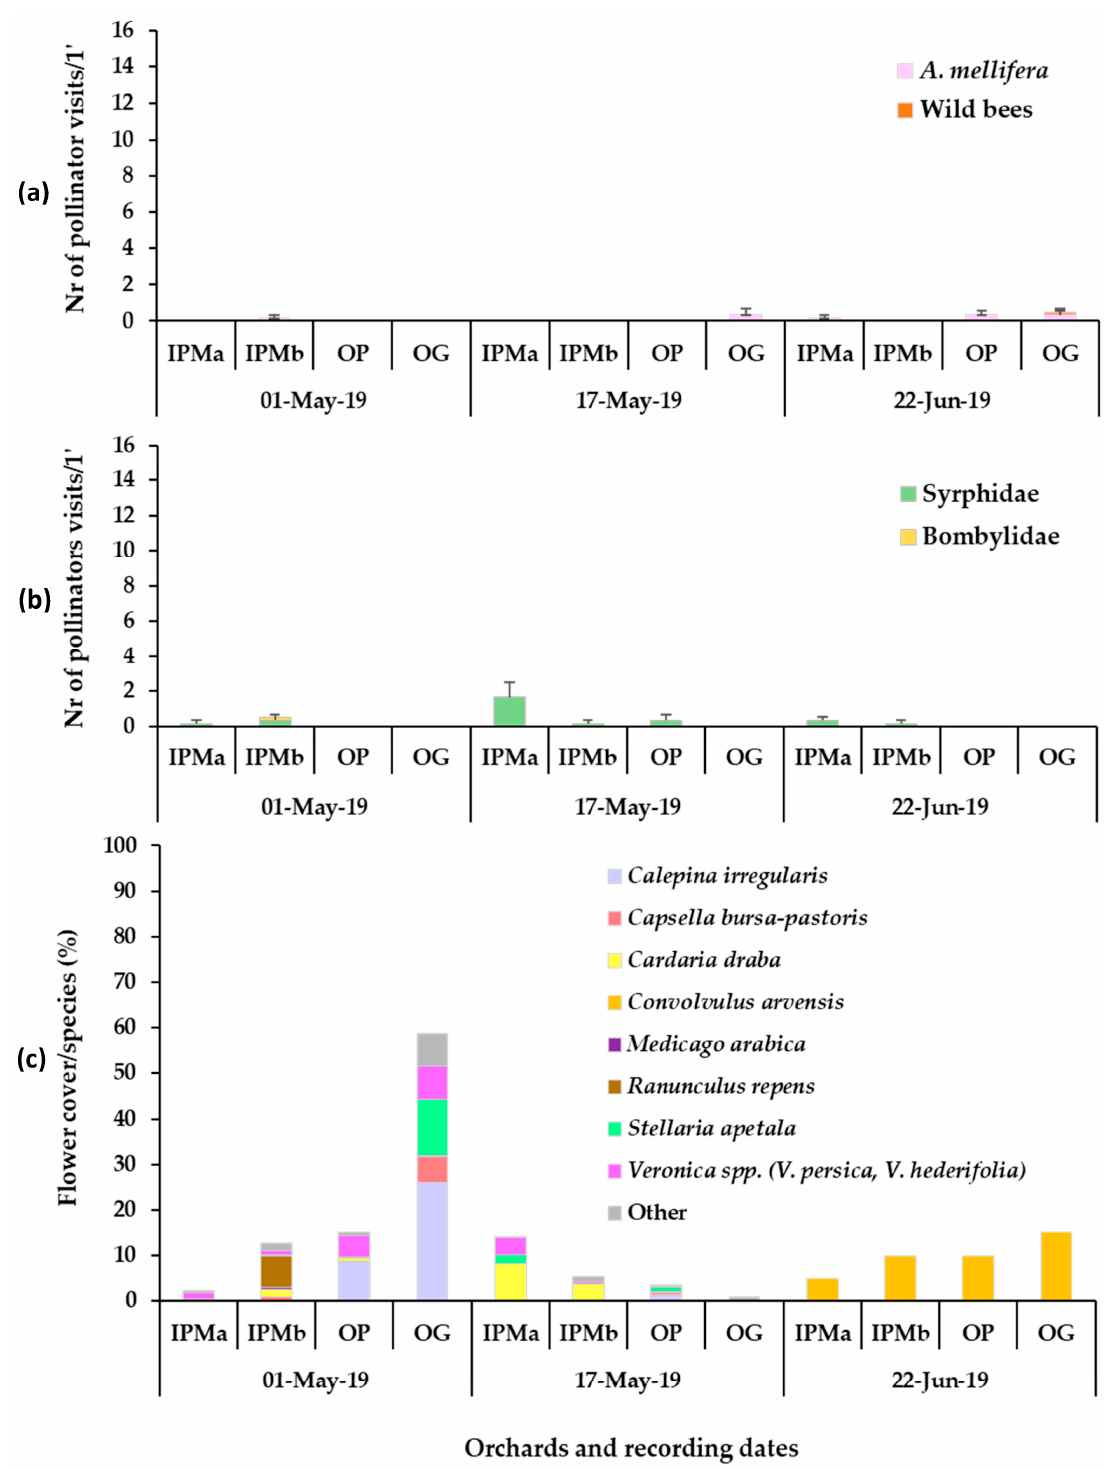
Figure 1. Mean numbers of ( a ) Hymenoptera (honey bees, wild bees), ( b ) Diptera pollinator visits recorded on groundcover patches of natural vegetation (wild plants) (1 min/6.4 m 2 ) and ( c ) mean flower cover percentage per plant species in the patches in apple orchards in the baseline year, 2019. IPMa: IPM field site a, IPMb: IPM field site b, OP: organic palmette field, OG: organic goblet field. Vertical bars represent standard error of means. Other species: Senecio vulgaris , Taraxacum officinale , Cardamine hirsute , Raphanus raphanistrum , Cerastium glomeratum , Euphorbia sp., Medicago polymorpha , Trifolium repens , Geranium disectum , Alopecurus myosuroides , Poa annua , Galium aparinae.